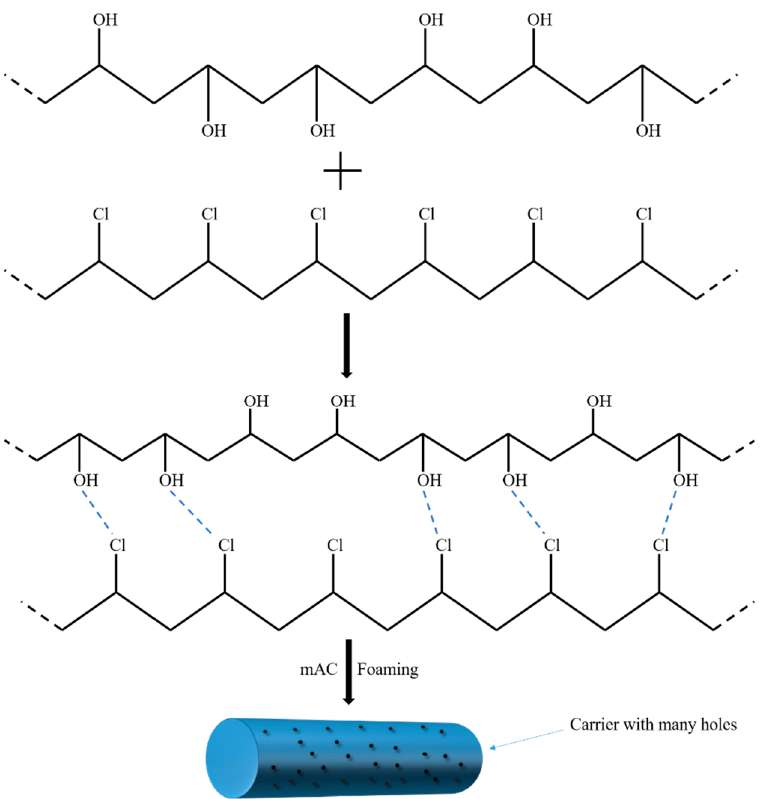
Figure 5. The reaction mechanism of PVC’s modification.